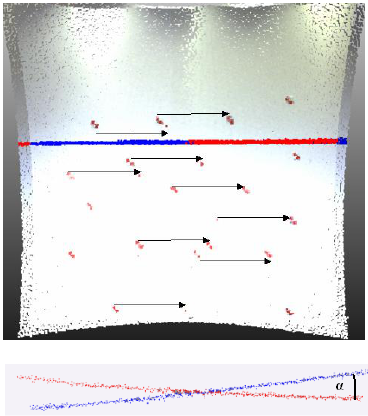
Figure 3 Recording a white wall (RGB-coloured pixel of coordinates) Upper part of figure 3 demonstrates overlaid pixel images of two local coordinate systems rotated against each other at an horizontal angle α. Arrows denote the amount of shift between the coordinate systems (red to blue) resulting from rotation. Measuring points - partly obscured due to the intersection between the images - are present for the purpose of demonstration and control only, not for the purpose of determinating α! The lower part of fig. 3 illustrates the angle α resulting from the overlay of the two local systems (which in this case is just an arbitrarily selected narrow horizontal strip viewed from above). Averaging of several thousand coordinate values makes sure that the noise accompanying a angle at a manageable